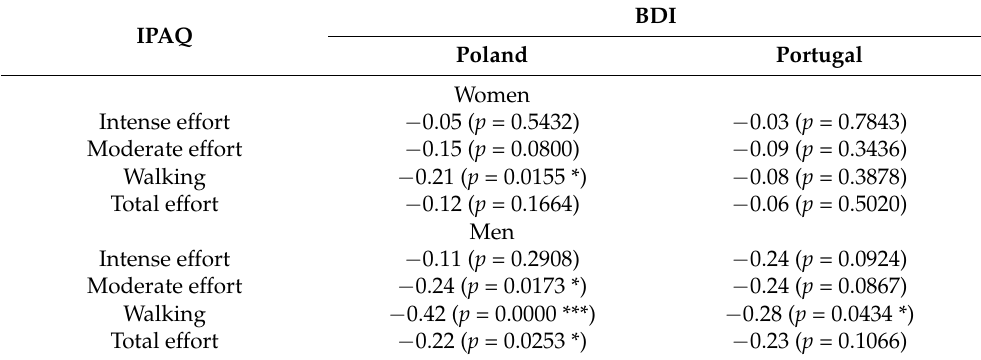
Table 7. Correlation coefficients between physical activity 19 and the BDI depression index.